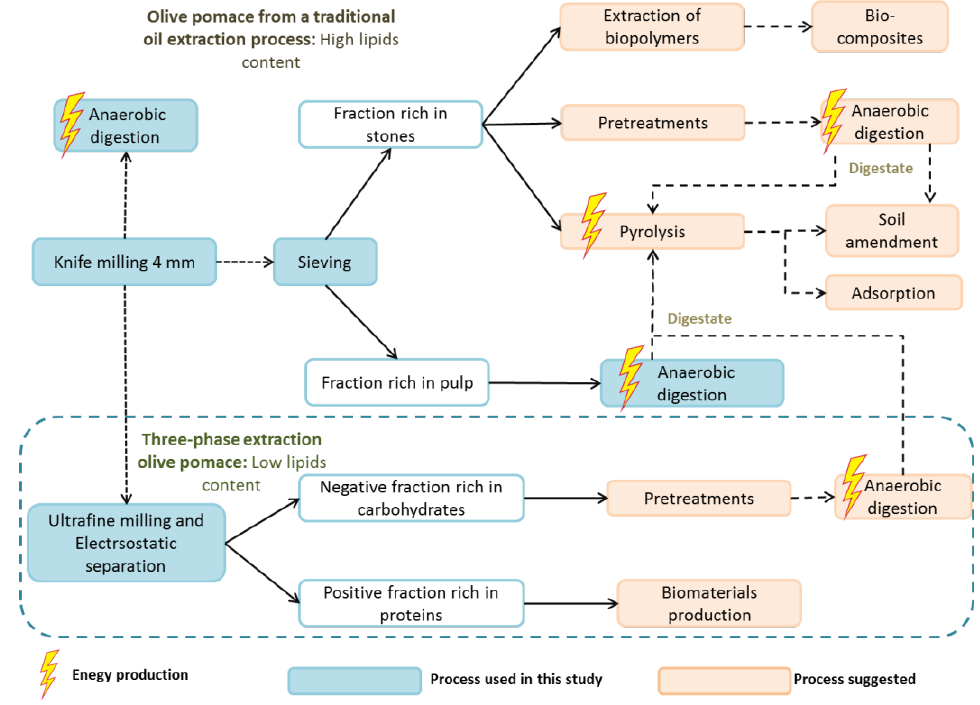
Figure 5. Valorisation routes suggested for all the studied fractions.